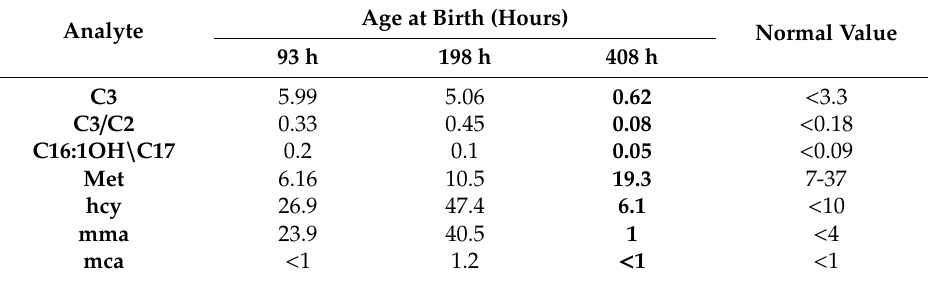
Table 1. Results of NBS and second level tests carried out at 93, 198, and 408 h from birth. Results of the test carried out after Vit. B12 treatment are highlighted in bold in the